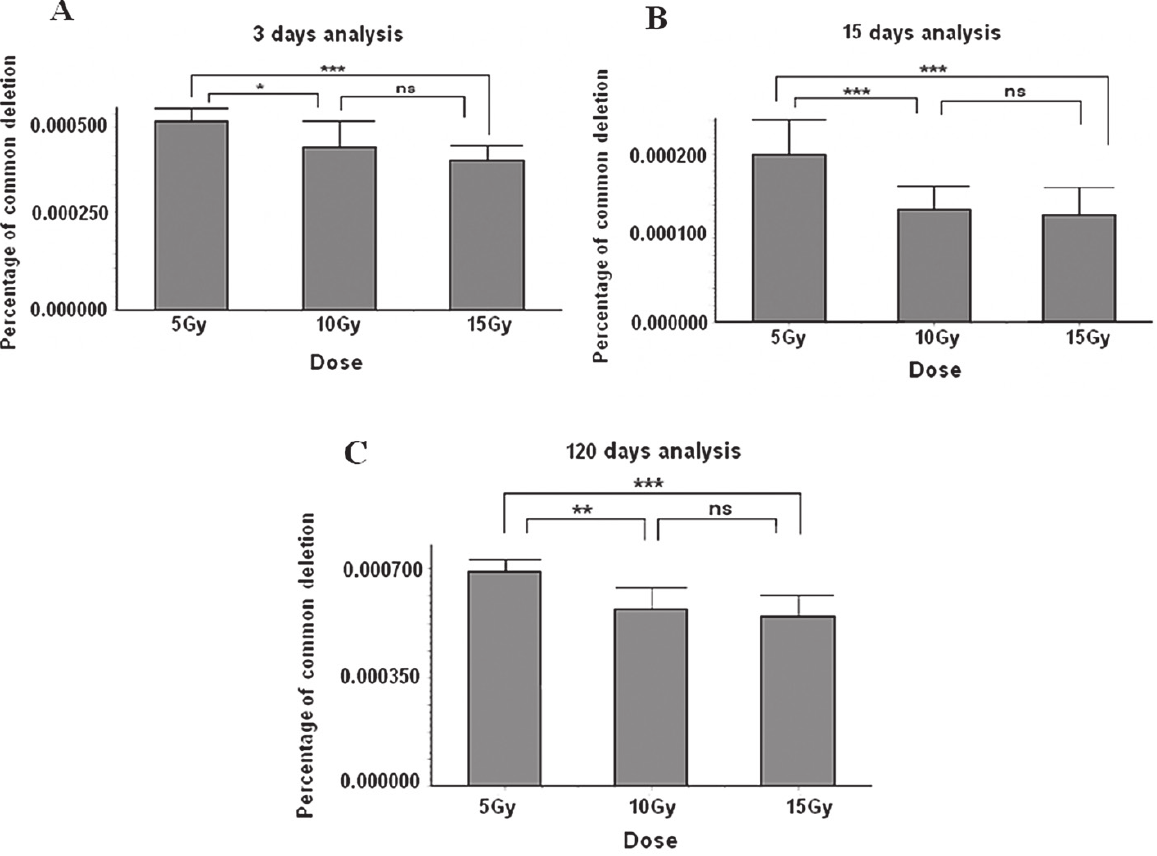
Figure 2 - Comparative analyses between the irradiated groups with doses of 5, 10 or 15 Gy at 3 days (A) , 15 days (B) and 120 days (C) after irradiation. The differences between the irradiated groups were analyzed with analysis of variance (ANOVA) and the Tukey-Kramer post hoc test. Error bars represent standard deviation (SD). Statistical significance was accepted when ( P < 0.05 *), ** ( P < 0.01) and *** ( P < 0.001); ns (difference not